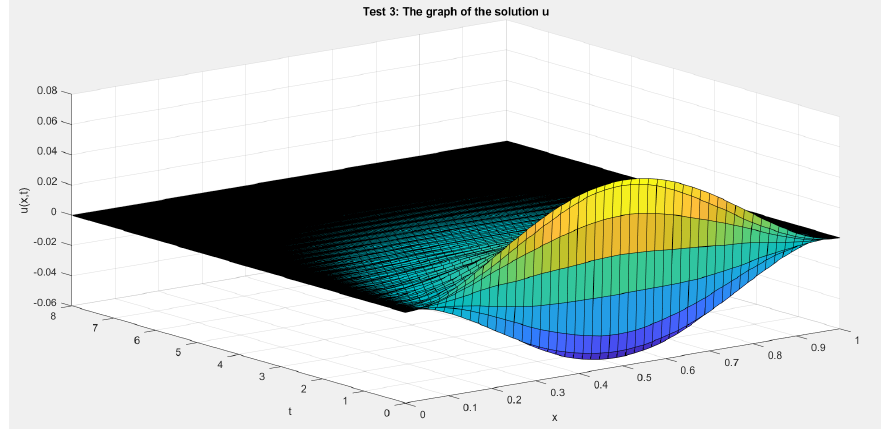
Figure 11. Test3: The solution u ( x , t ) .